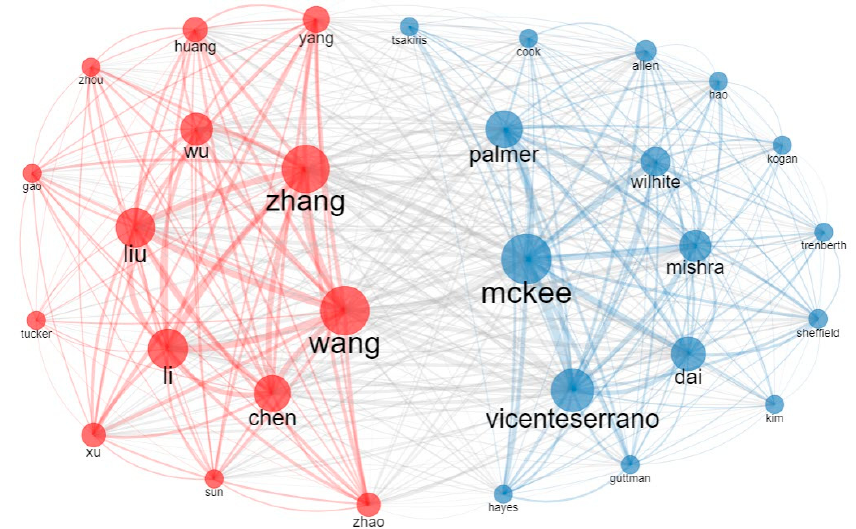
Figure 8. Visualization of author co-citation network in DI studies. Table 3 summarizes the top 20 DIs and the most applied countries. The top 15 countries were selected based on a higher number of publications, citations, and affiliations in the DI studies, whereas the DIs were selected based on the number of publications and frequency of use by countries. Countries are listed in alphabetical order. DIs were categorized as meteorological, soil moisture (agricultural), hydrological, remote sensing, and composite (or modeled). Then, the DIs were listed in alphabetical order in each